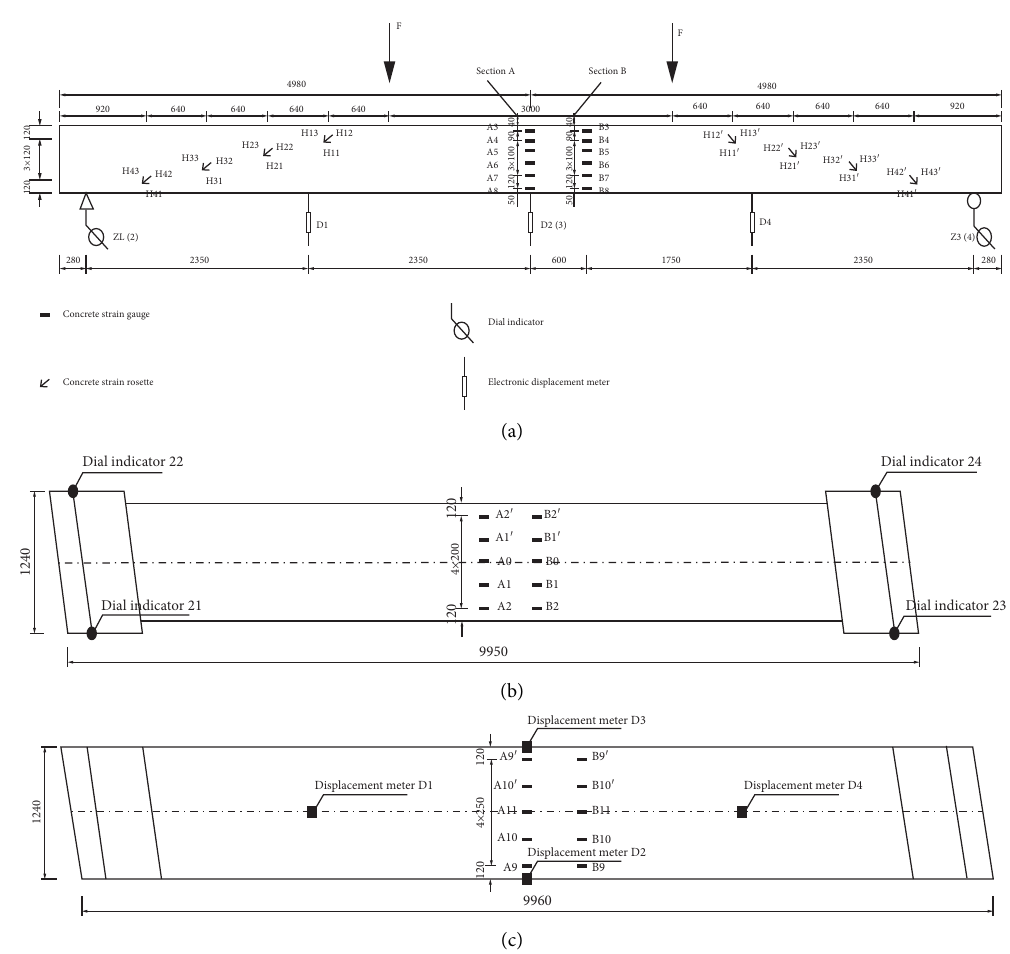
Figure 4: Layout of measuring points on the sample. (a) Elevation of the specimen. (b) Top view of the specimen. (c) Bottom view of the